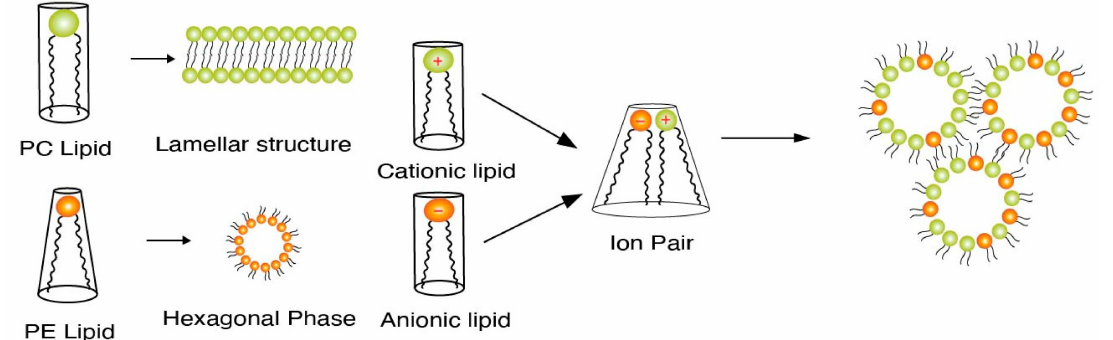
Figure 1. Figure depicting ion pair formation and subsequent formation of a hexagonal phase as a precursor to the assimilation/disruption of the endosomal membrane